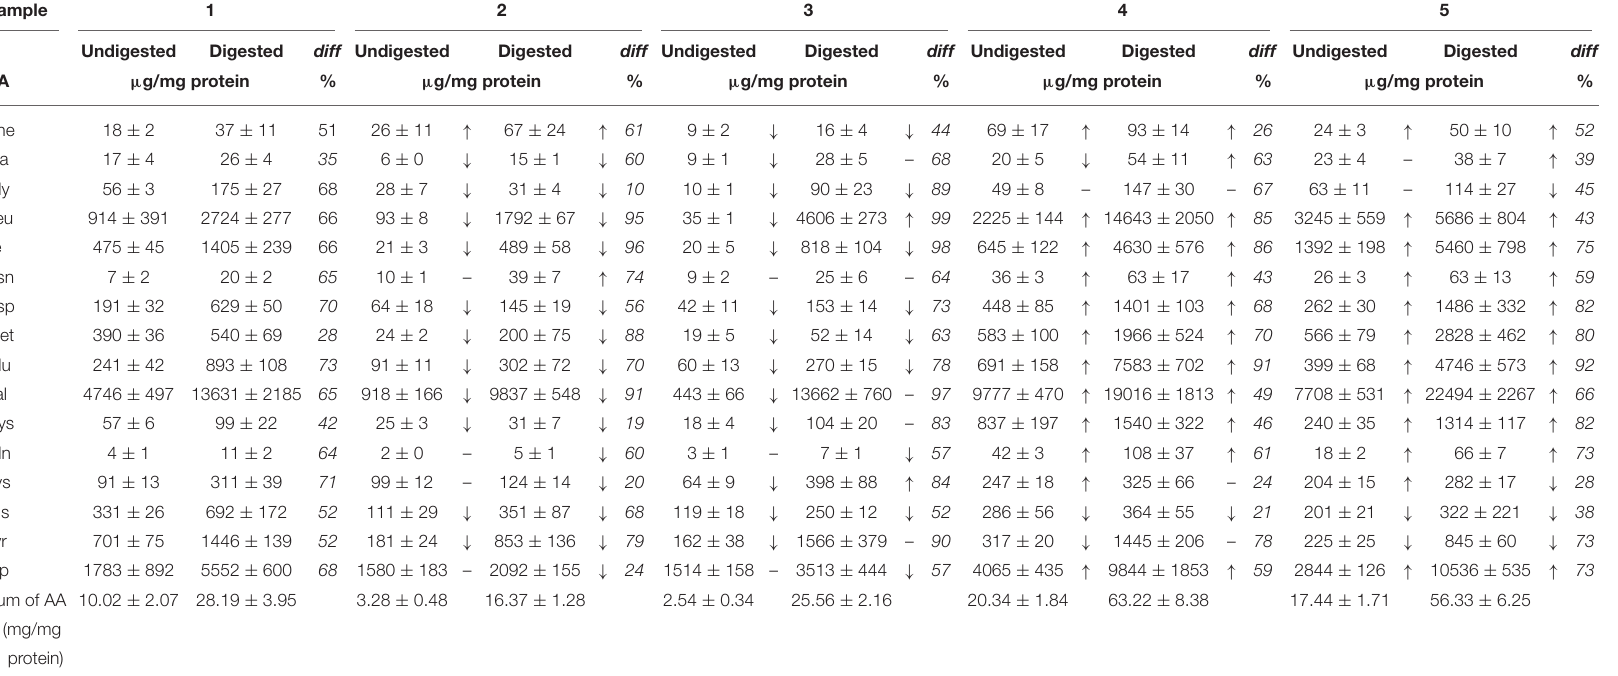
TABLE 2 | Released amino acids from pea flour before and after